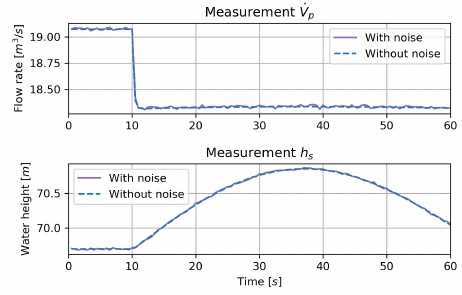
Figure 2: Measurements from the simplified hy- dropower model with and without noise for the dynamic simulations.